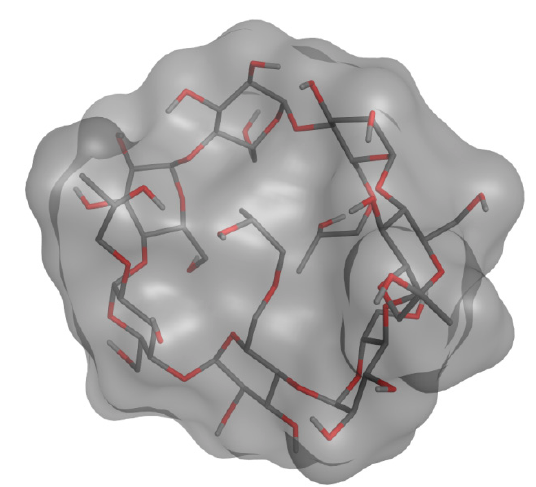
Figure 15. Structure of the closed conformation of the HP- β -CD model with two substitutions on the wide rim and other two substitutions on the narrow rim.